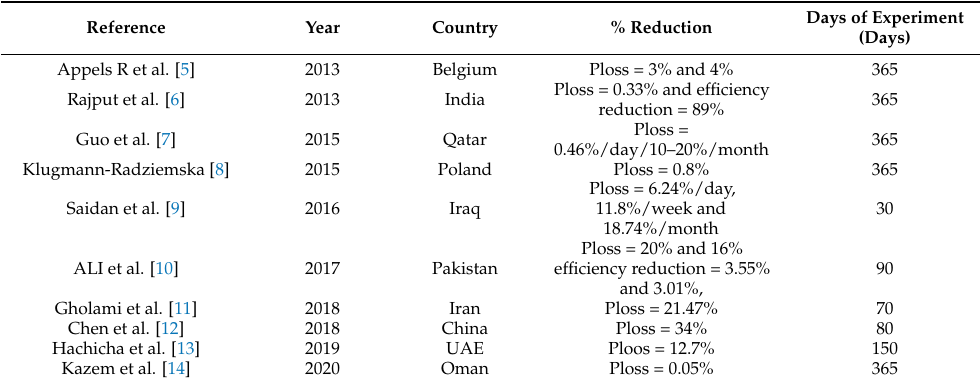
Table 1. Summary of some published studies in